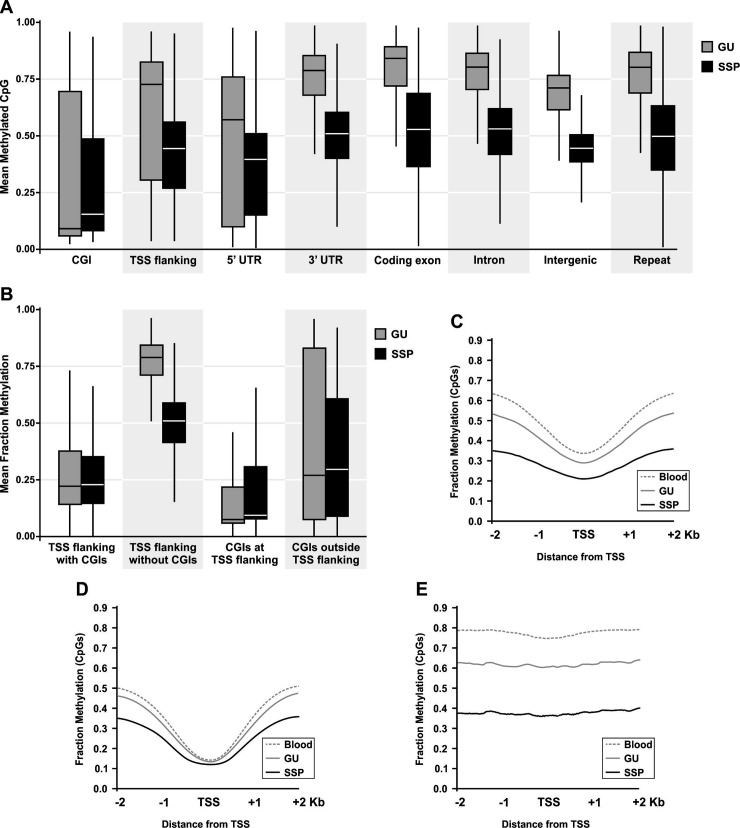
SSP-specific gain of methylation targets CGIs.(A) The global loss of methylation in SSP genome is detected all over the genome except at CGIs. The CGIs show the lowest level of DNA methylation in GU tissue, and gain methylation in the SSP tissue. The TSS 4Kb flanking regions and 5’UTRs show lower level of methylation loss compared to other regions of the genome. (B) TSS flanking regions that are located at CGIs have low level of CpG methylation. Although TSS flanking regions that are not part of CGIs show methylation level close to the genomic level. CGIs that are located at TSS flanking regions show lower level of methylation than CGIs that are not located around TSS. (C) Average of methylation on 4Kb TSS flanking regions of all Ensemble transcripts. (D) Average of methylation on 4Kb TSS flanking regions of Ensemble transcripts that include CGIs in that 4 Kb. (E) Average of methylation on 4Kb TSS flanking regions of Ensemble transcripts that do not include CGIs in that 4 Kb.